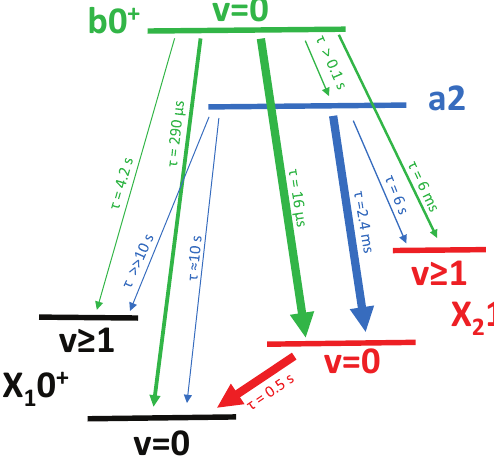
Figure 2. Relevant spontaneous emission channels and partial lifetimes of TeH + . Line thicknesses (not to scale) represents the branching ratios of each excited